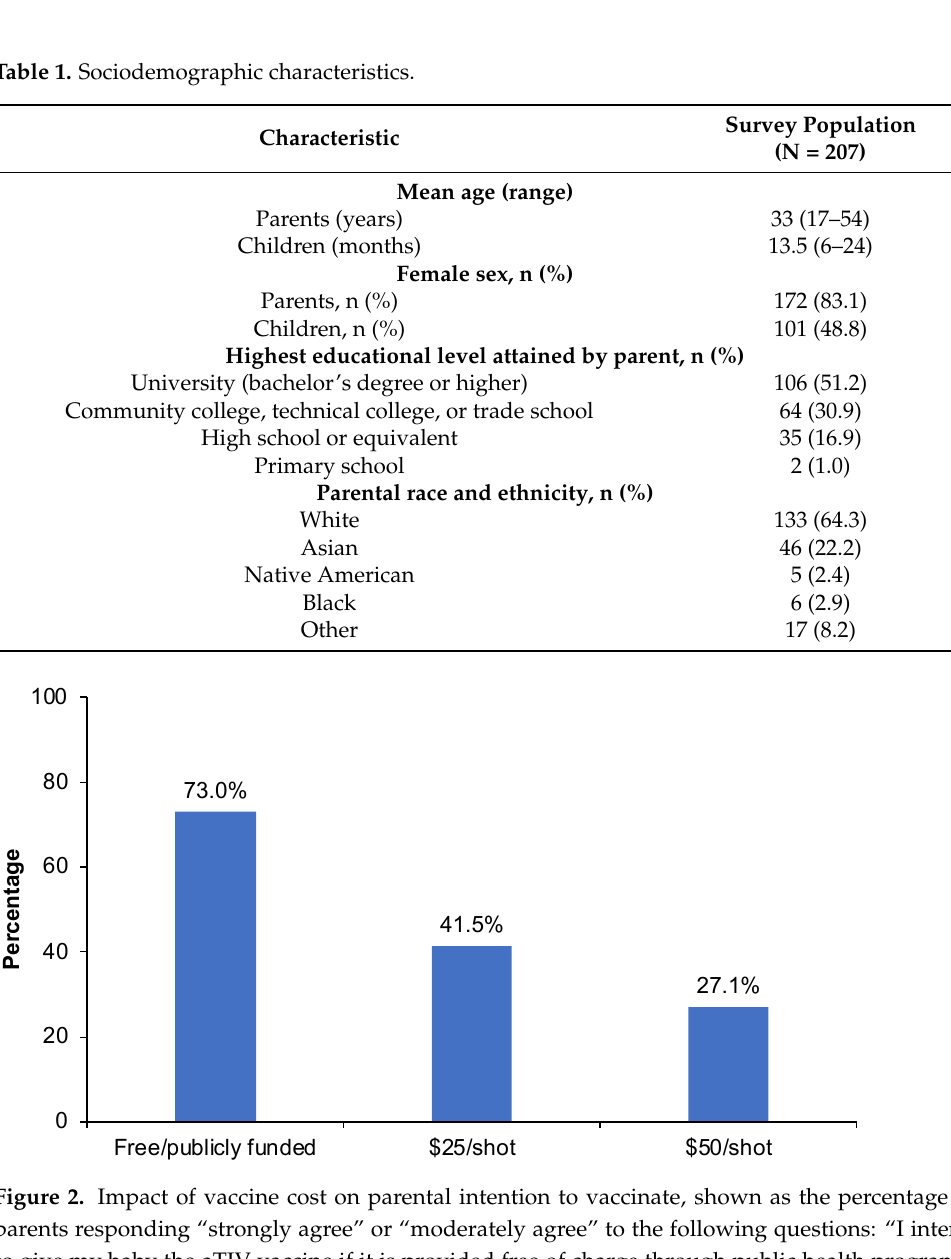
4 of 7 Table 1. Sociodemographic characteristics.